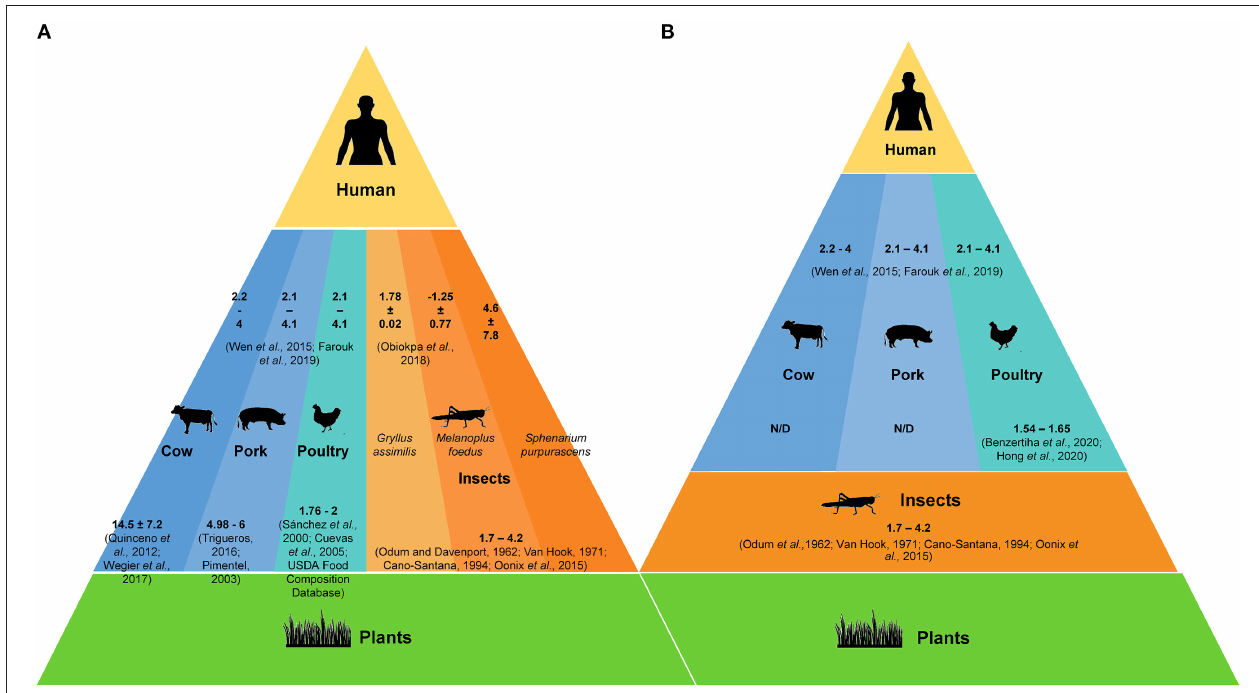
Frontiers in Sustainable Food Systems |